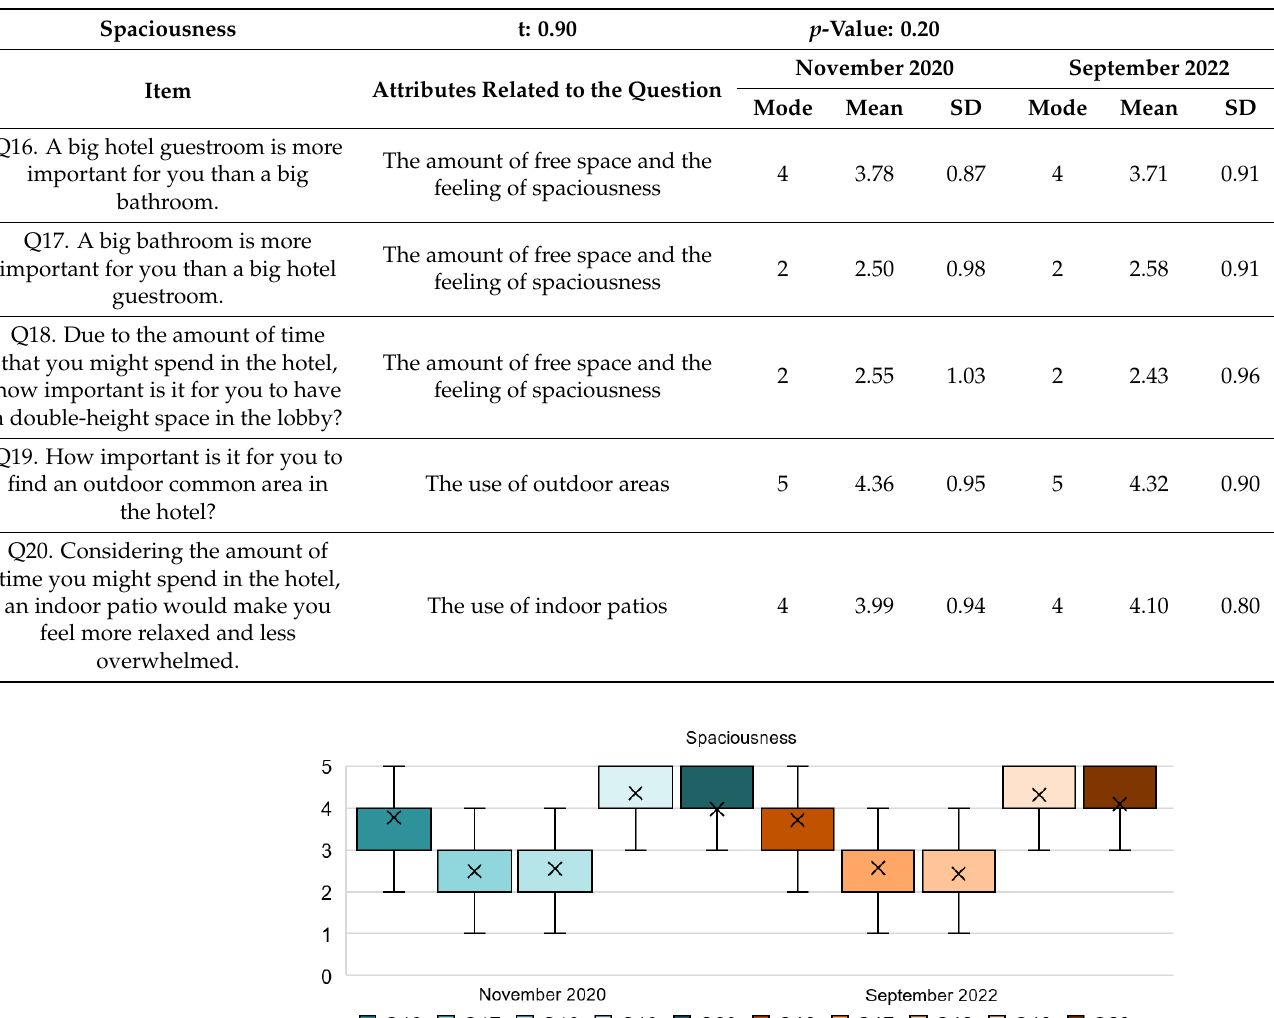
Table 5. Interval data analysis of the Spaciousness dimension.